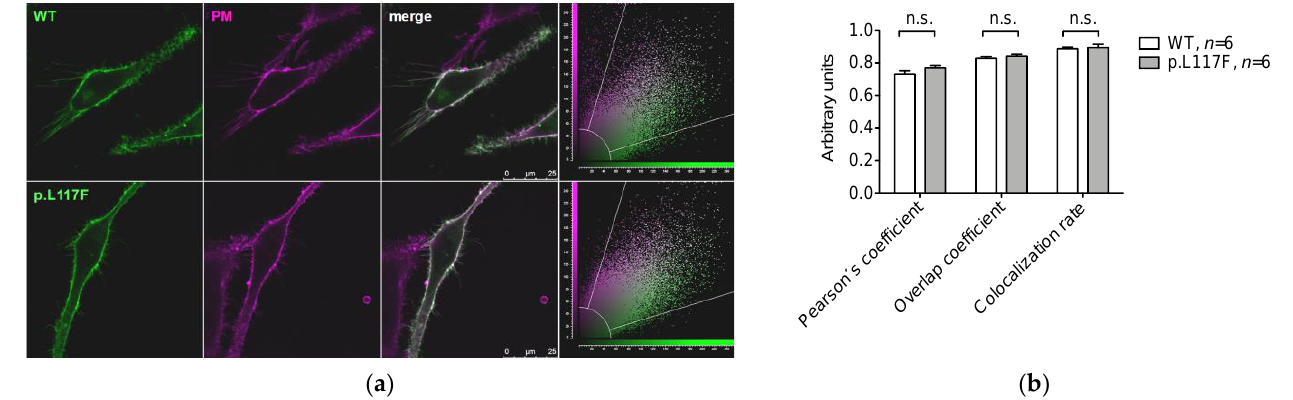
Figure 3. Colocalization of human wild-type pendrin and pendrin variant p.L117F with the plasma membrane. ( a ) Representative images of living Hela cells transfected with wild type (WT) or p.L117F SLC26A4 -EYFP (green) and stained with the plasma membrane (PM) marker CellMask TM Deep Red (magenta). The corresponding merge images and scatter plots are shown. Scale bar: 25 µ m. ( b ) Average Pearson ’ s correlation coefficient, overlap coefficient, and colocalization rate. n refers to the number of cells from 3 independent subcultures. n.s., not significant, unpaired, two-tailed Student´s t test.